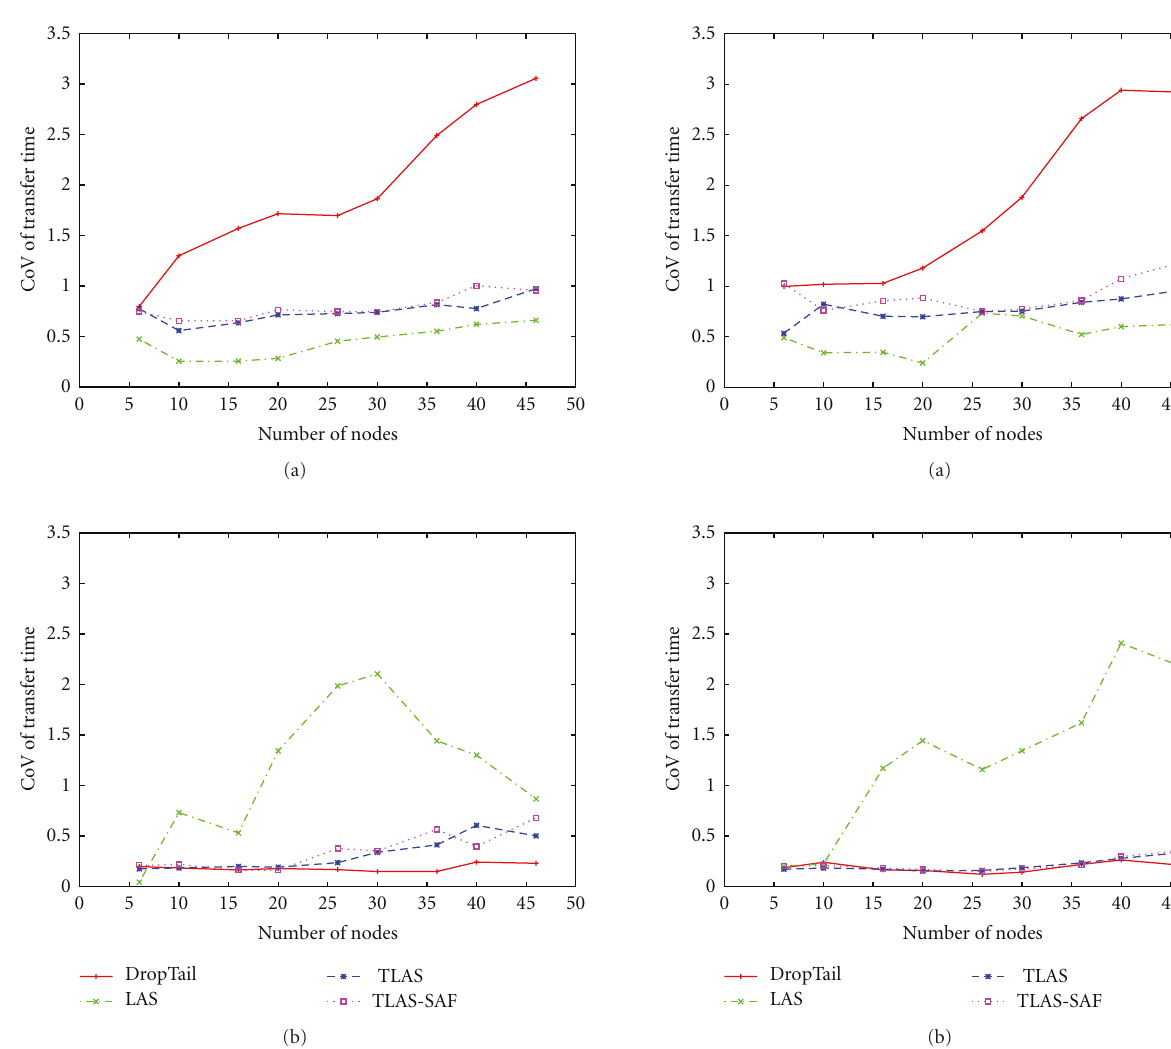
Figure 6: CoV of transfer time under TLAS-SAF and other studied policies (short flows inter-arrival time = 250 ms): (a) small files. (b) large files.